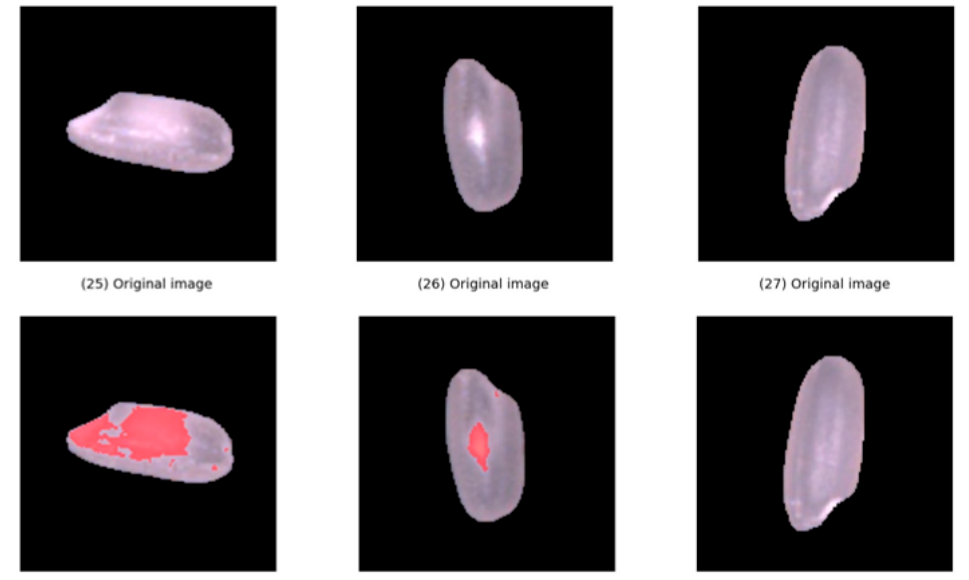
Figure 13. Image visualization of a single polished rice grain. Table 6. Statistical results of rice grain types after improvement.